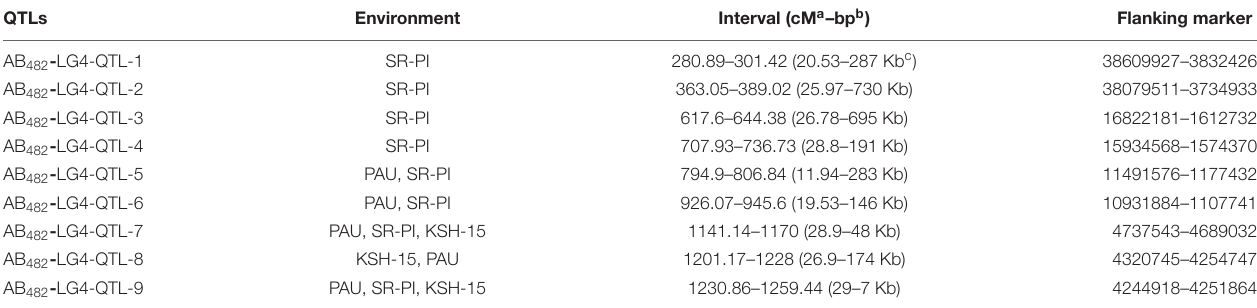
TABLE 6 | Quantitative trait loci associated with AB resistance identified in the ILC482 × ILC1929 population of chickpea in chromosome